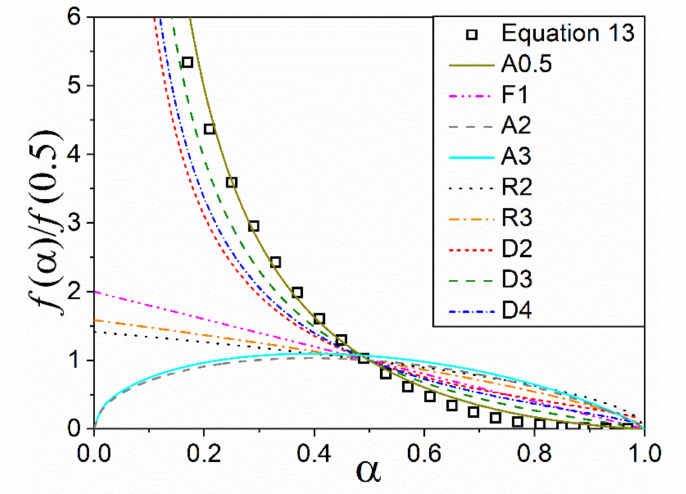
Figure 4. Comparison between the modified Sestak–Berggren equation obtained from combined analysis (open black squares) and some ideal kinetic models from the literature (lines)